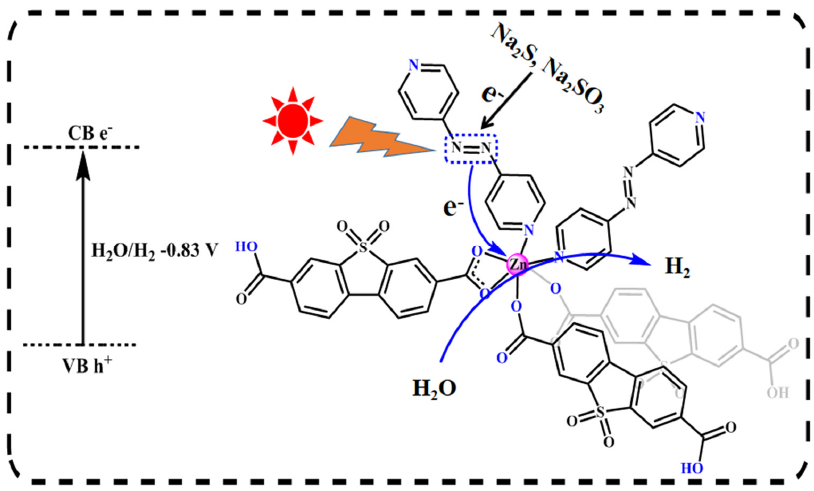
Figure 8. Proposed photocatalytic mechanism of hydrogen evolution for Zn-MOF under visible- light irradiation.